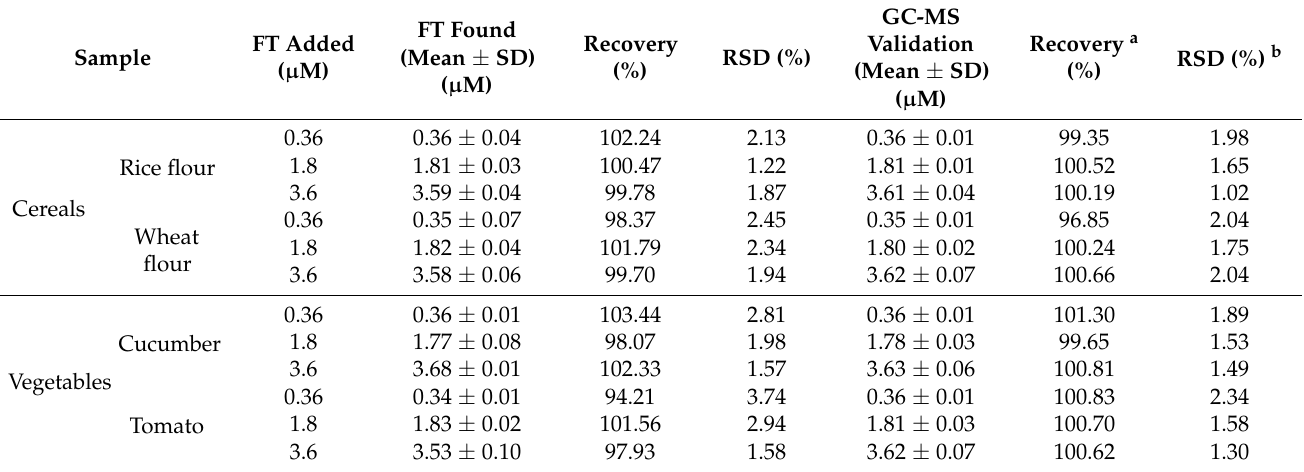
Table 1. The recovery was obtained for the analysis of agricultural product samples ( n =